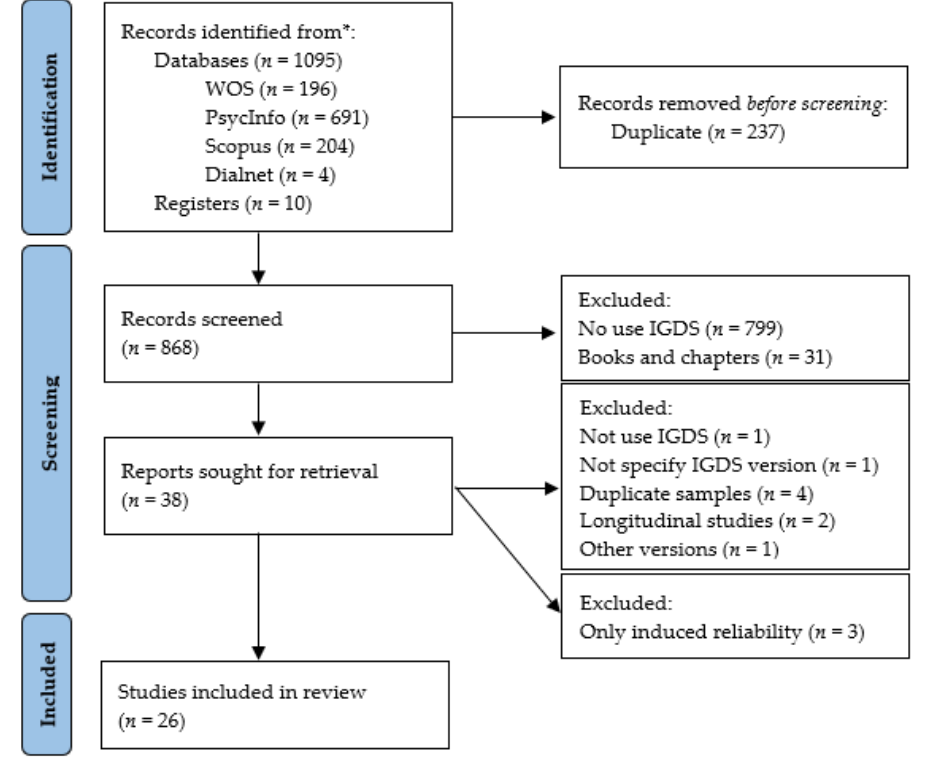
Figure 1. Flowchart of the selection and screening process of the systematic review articles according to the PRISMA 2020 statement.